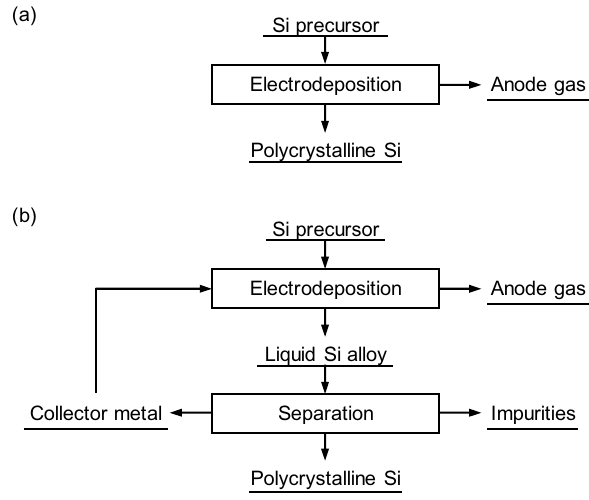
Figure 14: Flowcharts for the electrochemical production of Si in ( a ) direct production of solid Si and ( b ) production of Si by using liquid Si alloy as an intermediate